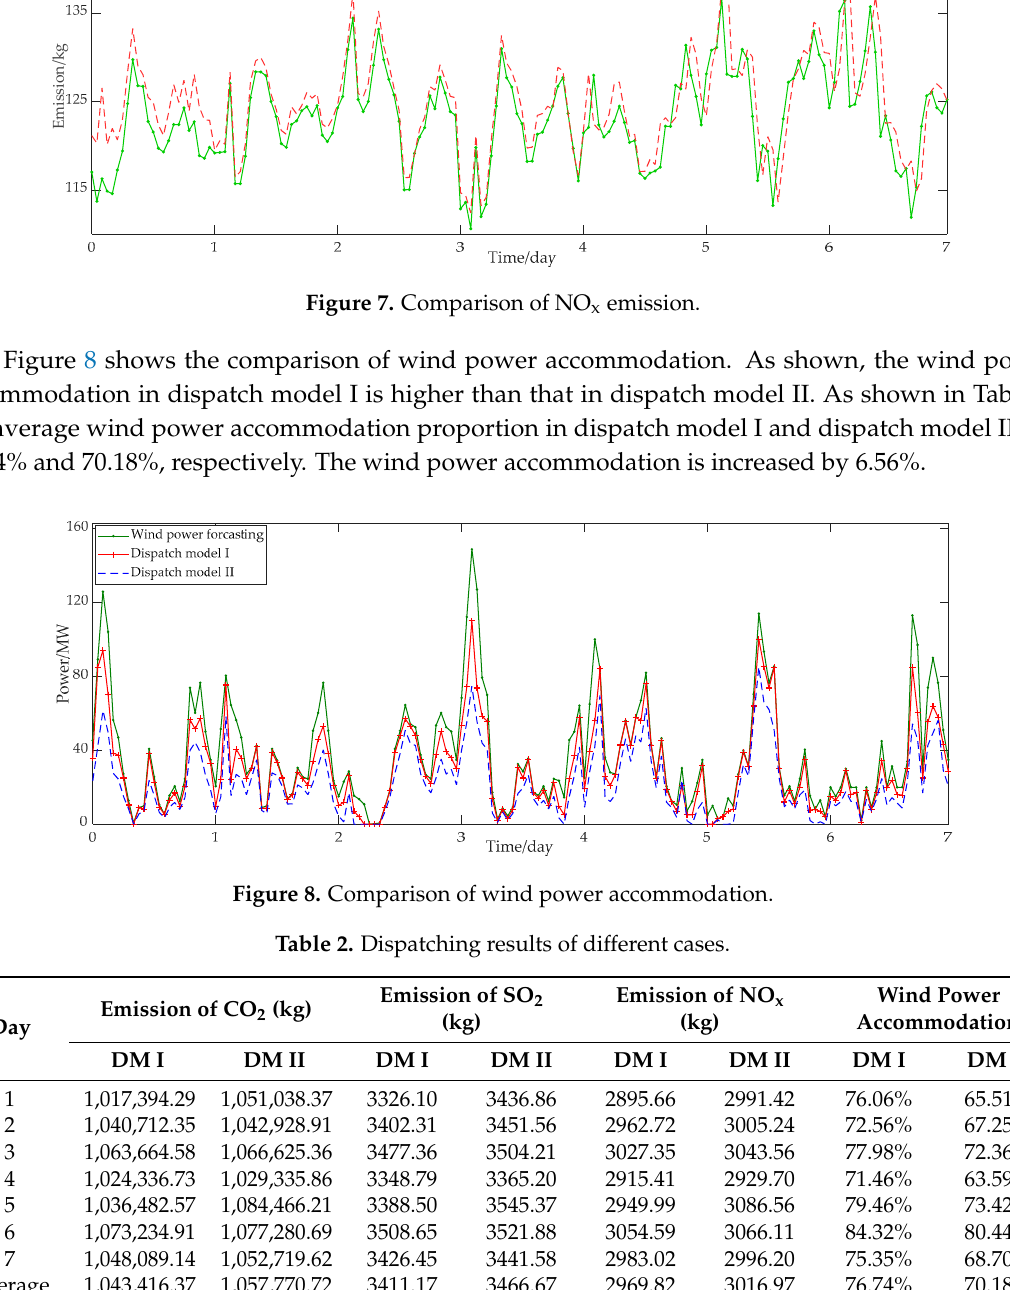
Figure 6. Comparison of SO 2 emission.